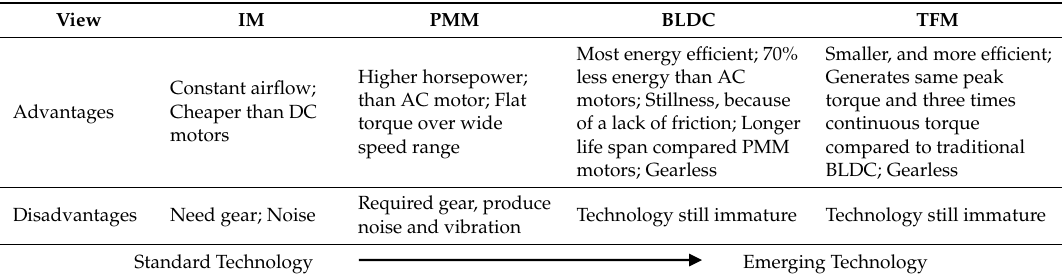
Table 2 . The electric motor for monstrous fan application .